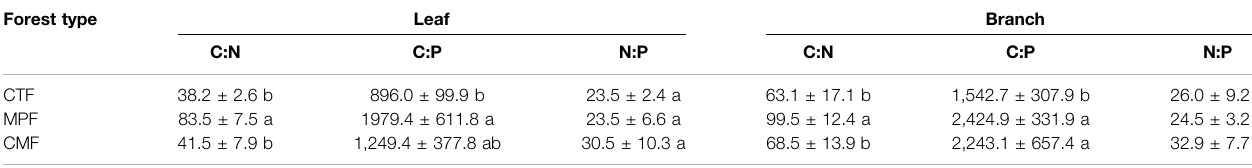
TABLE 5 | Characteristics of litter CNP stoichiometry in the three examined subtropical forest types.